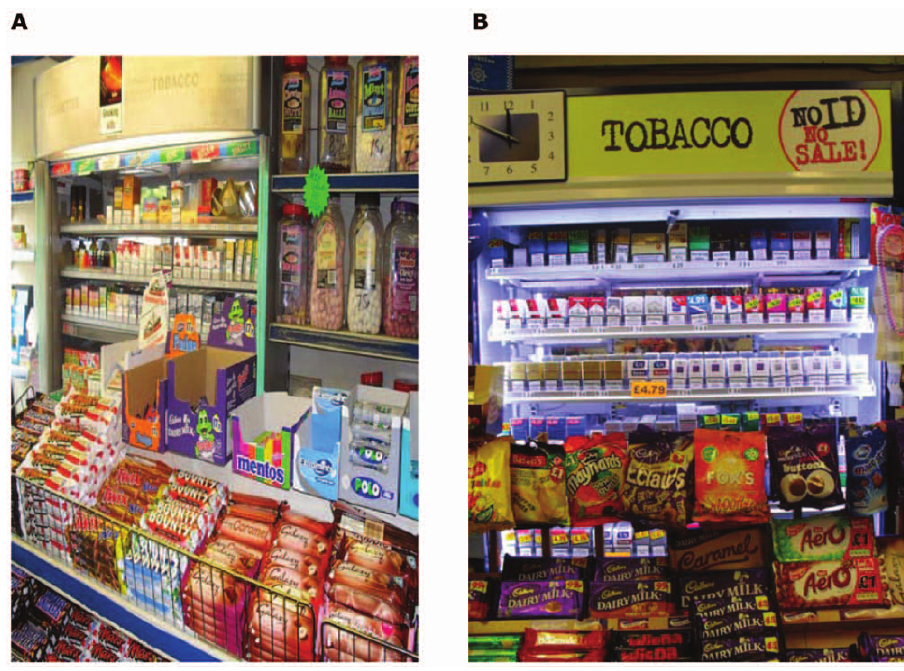
Figure 4. Tobacco displays in close proximity and in the same visual field with sweets.